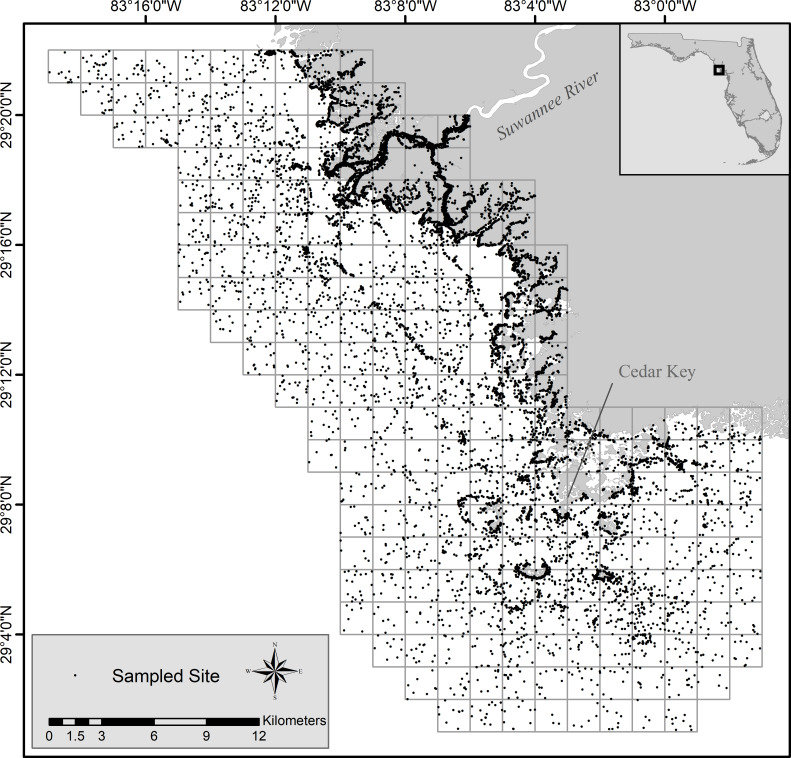
Map of study area, showing all randomly selected sample sites, 1997–2018.The grid system represents the Fisheries Independent Monitoring program’s universe.